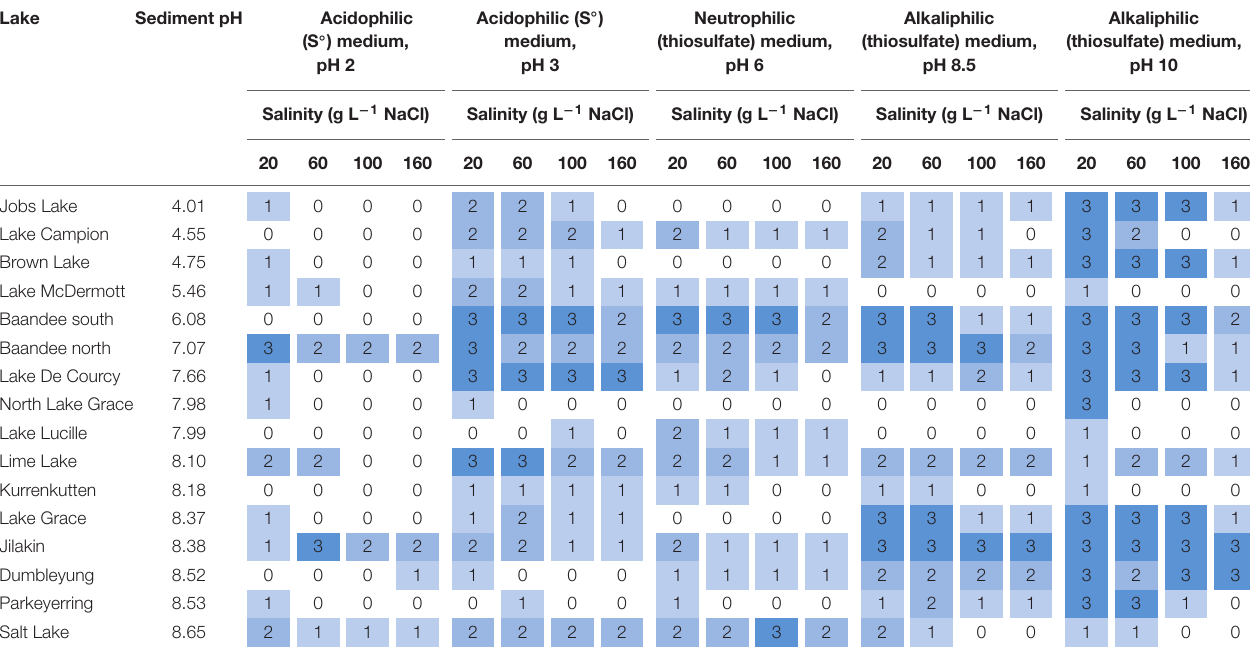
TABLE 4 | Sulfur oxidation activity in saline enrichment